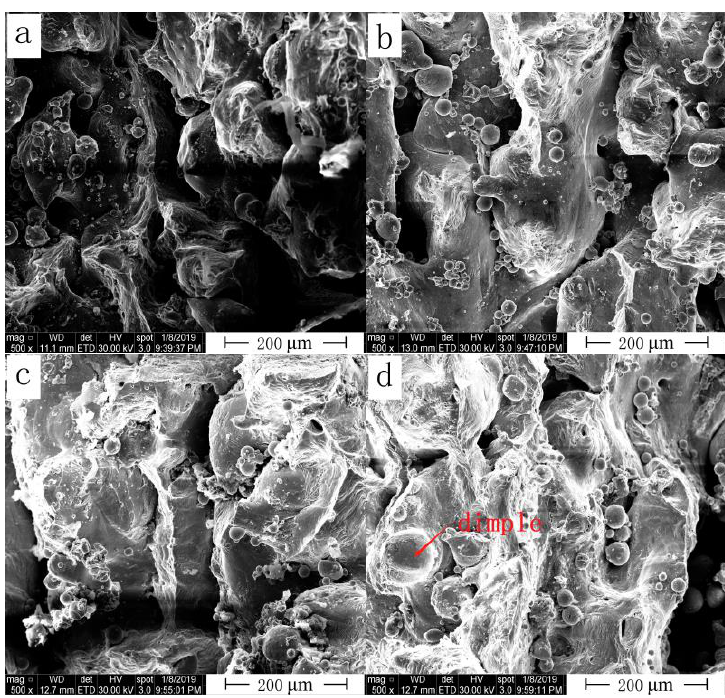
Figure 10. Fracture morphology of the SLM alloy formed at different laser powers ( a ) 380 W, ( b ) 400 W, ( c ) 440 W and ( d ) 460 W.